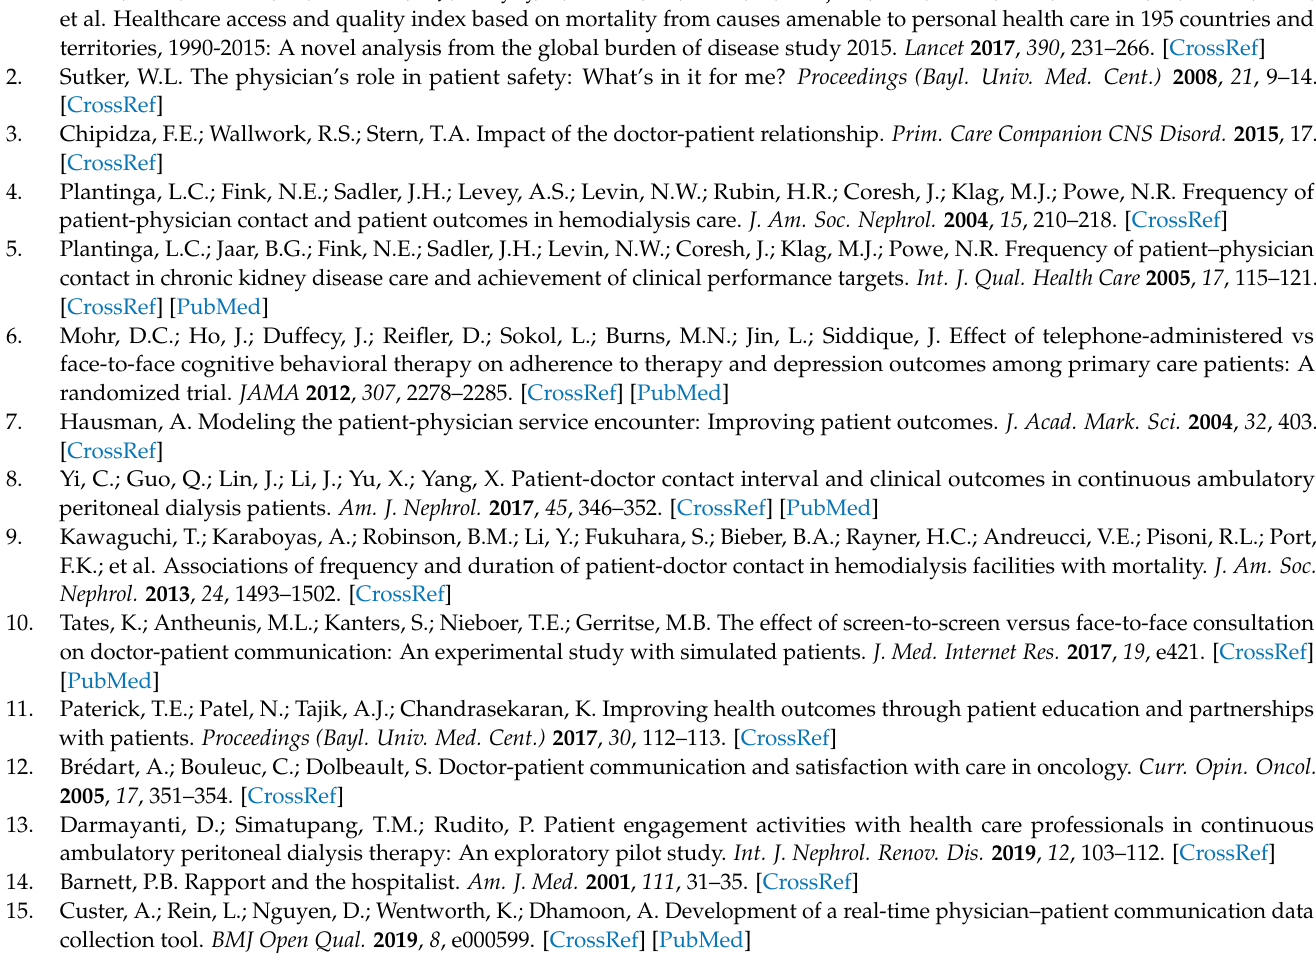
Table S5: Results of logistic regression analysis on the time to response a medical call compares to